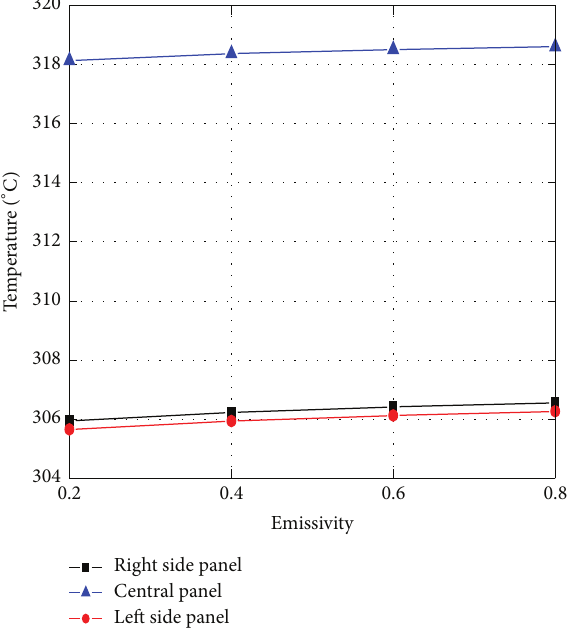
Figure 9: Average wall temperature of absorber